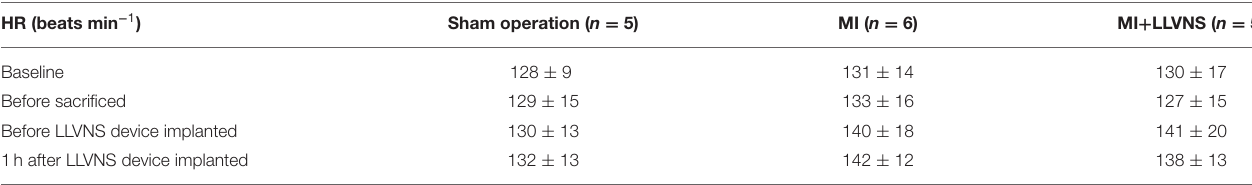
TABLE 1 | The effect of low level vagus nerve stimulation on heart rate. HR (beats min − 1 ) Sham operation ( n = 5) Baseline Before sacrificed Before LLVNS device implanted 1h after LLVNS device implanted LLVNS, low level left vagus nerve stimulation; MI, myocardial infarction; HR, heart